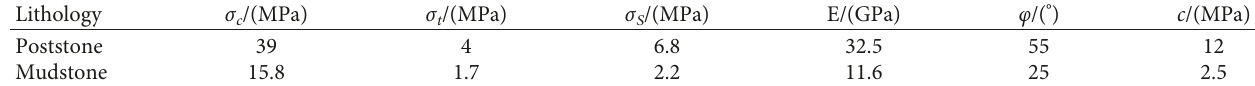
Table 2: Mechanical properties of concrete materials and high-water